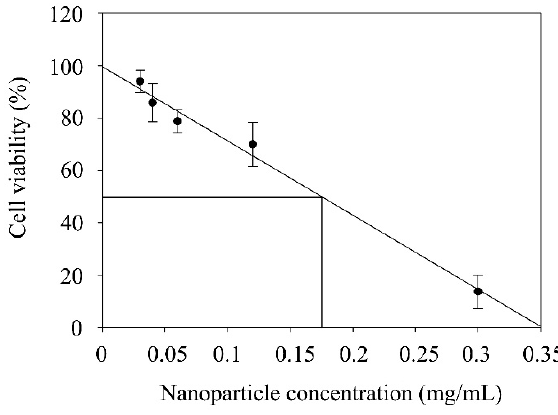
Figure 6. Dose response curve (R 2 = 0.9881) obtained from cell viability data at several RFB-loaded NLC concentrations. IC 50 was calculated as the concentration of nanoparticles producing a 50% reduction in cell viability.